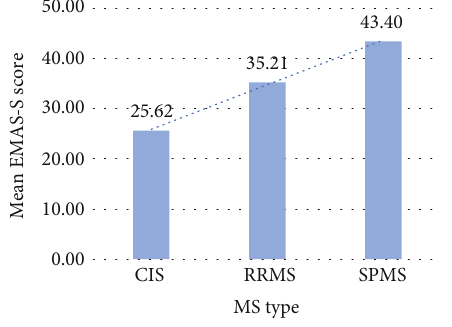
Figure 3: Anxiety score according to MS type. Table 4: The correlation matrix for tested variables.